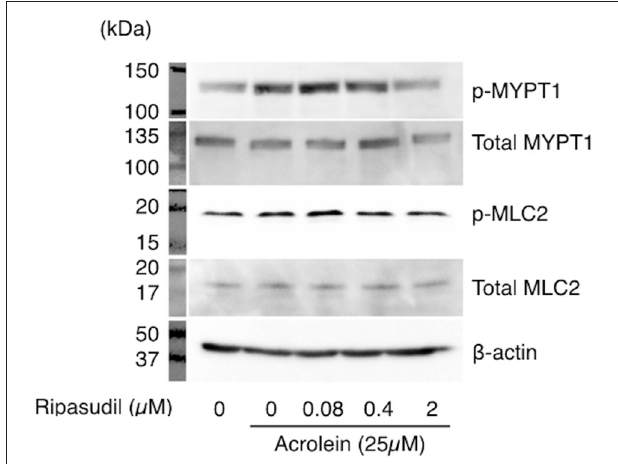
FIGURE 5 | Changes in phosphorylation of MYPT1 and MLC2 in TR-MUL5 cells treated with acrolein and ripasudil. Phosphorylation levels of MYPT1 and MLC2 in TR-MUL5 cells after acrolein stimulation. Ripasudil suppressed the increase of phosphorylated forms of MYPT1 and MLC2 induced by acrolein stimulation in TR-MUL5 cells.